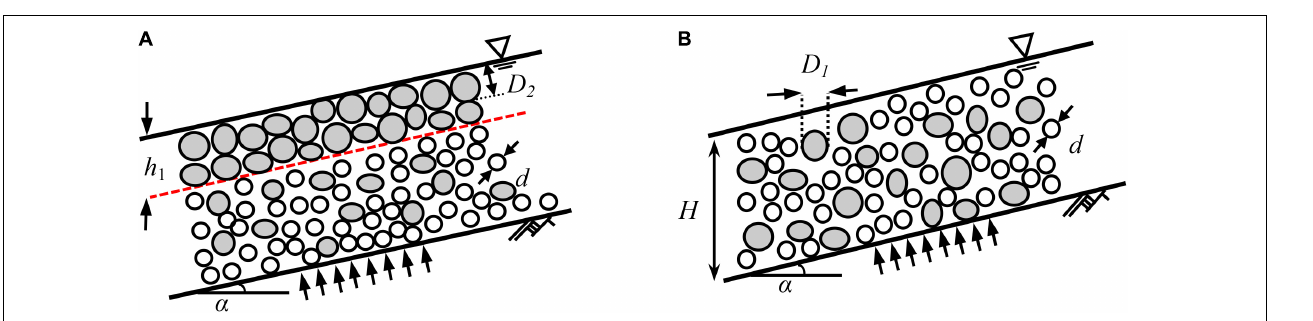
FIGURE 6 | Debris flow with overlying coarse-grain layer (A) or mixed grains (B)